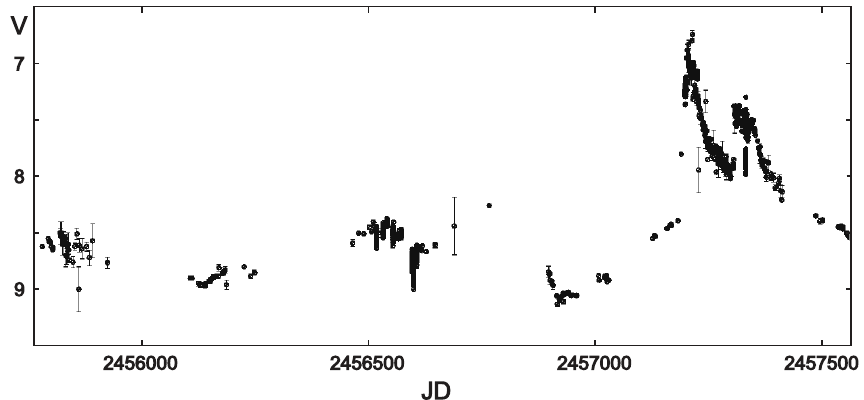
Fig. 2. AAVSO V -band light curve of the symbiotic nova AG Peg before and during the outburst of